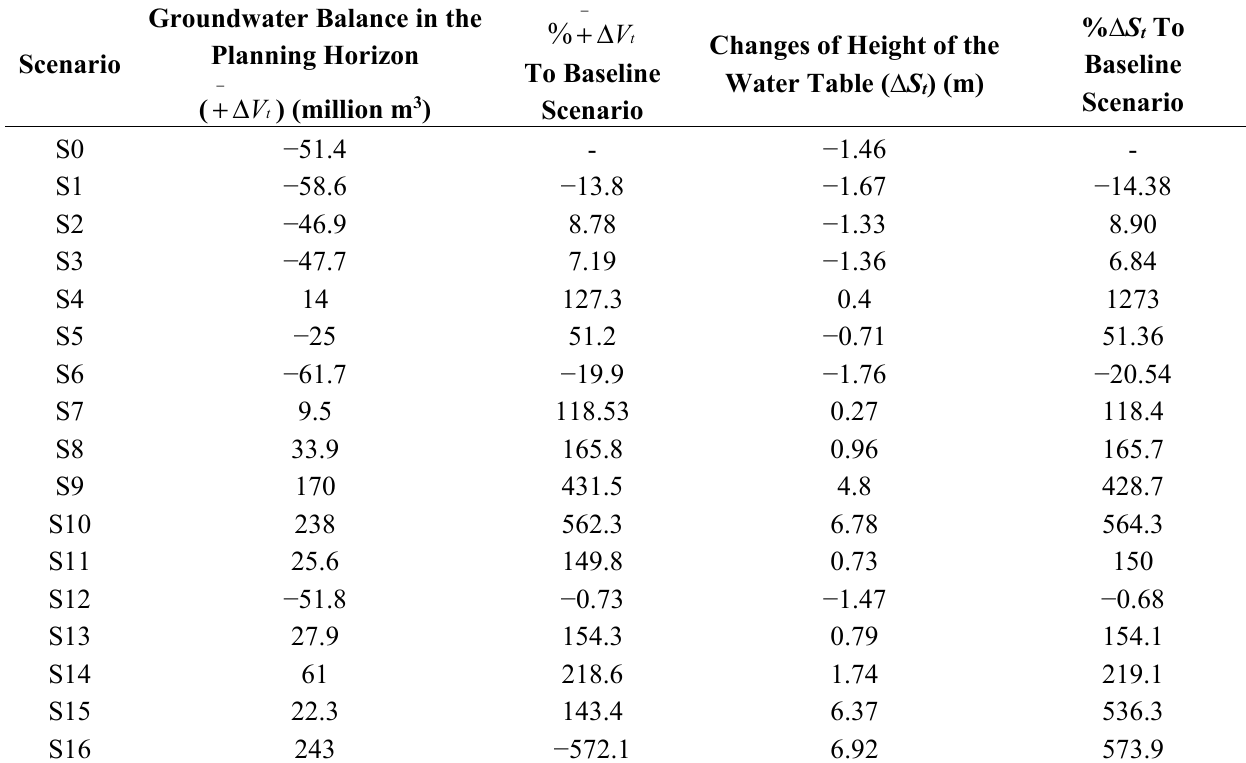
Table 3. Groundwater volume fluctuations under different economic scenarios in Normal climate conditions on the planning horizon